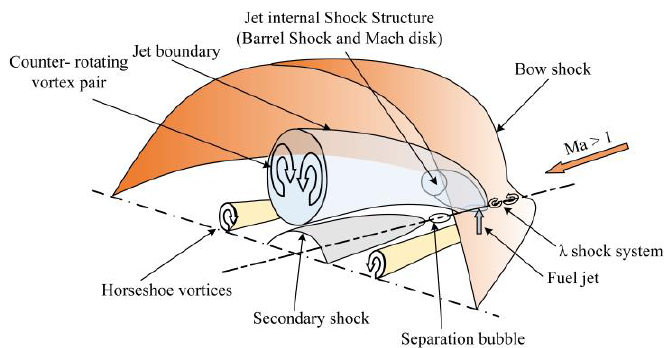
Figure 1. Schematic diagram of a transverse jet inside the supersonic mainstream.